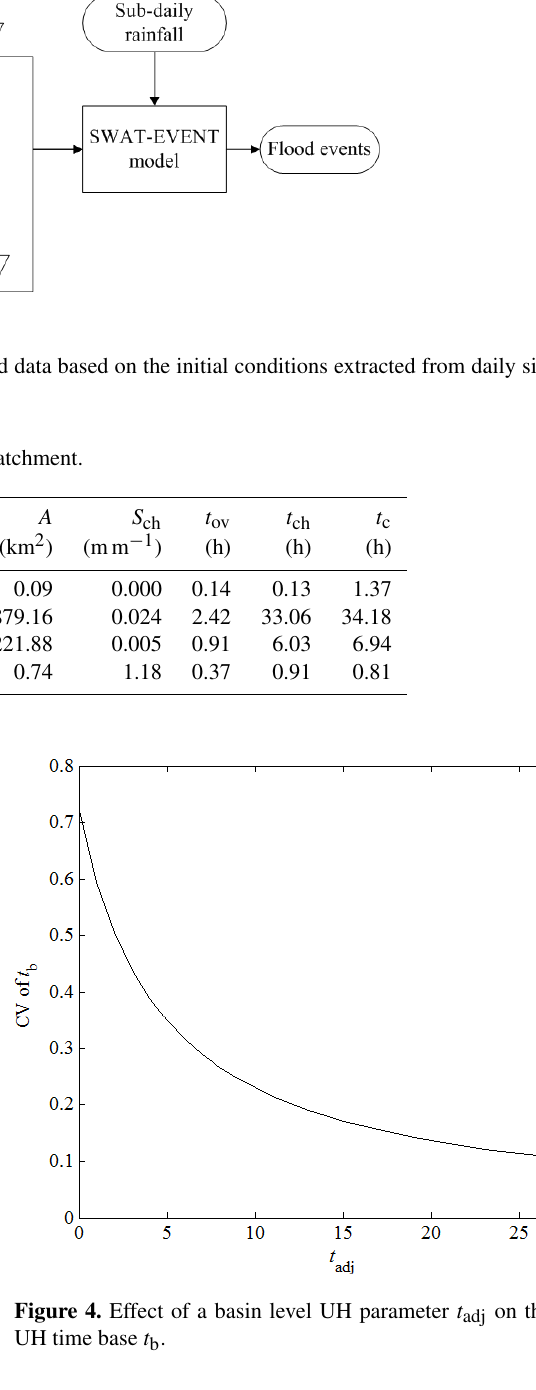
sub-basins than those in downstream sub-basins. Spatially,